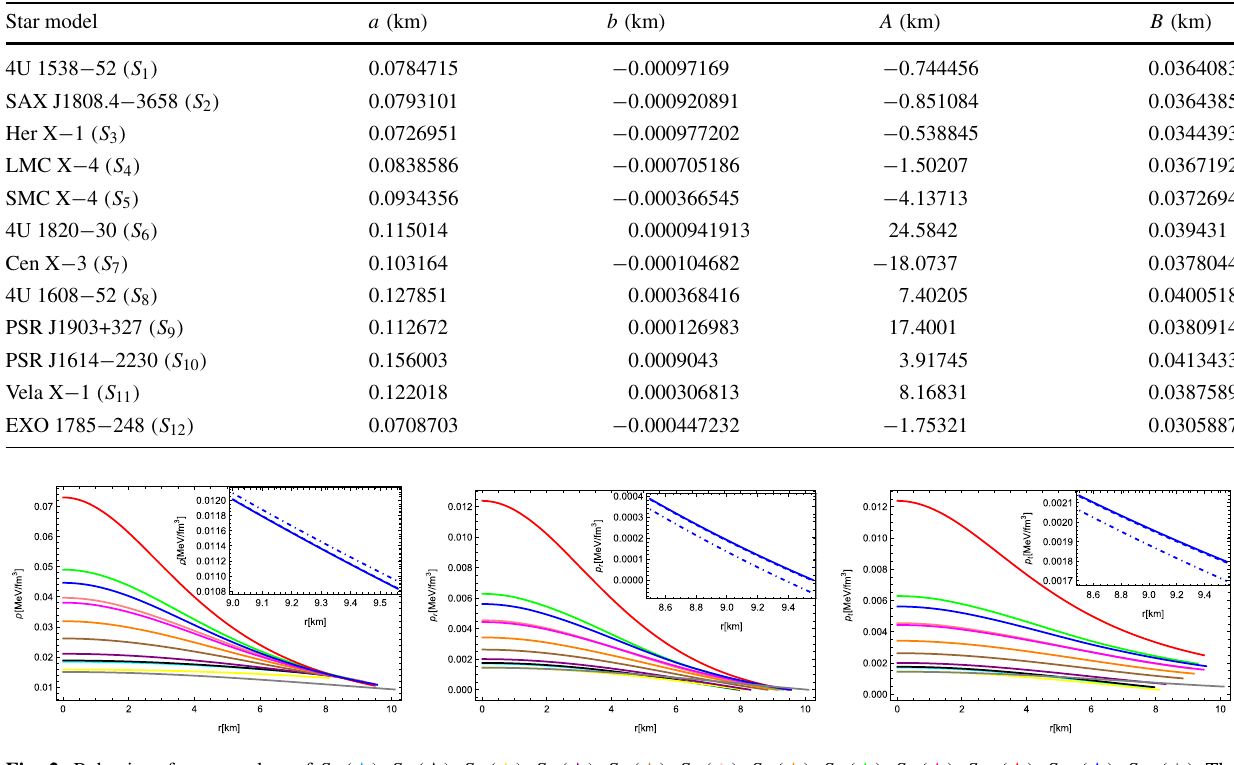
Fig. 2 Behavior of ρ , p r and p t of S 1 ( (cid:2) ), S 2 ( (cid:2) ), S 3 ( (cid:2) ), S 4 ( (cid:2) ), S 5 ( (cid:2) ), S 6 ( (cid:2) ), S 7 ( (cid:2) ), S 8 ( (cid:2) ), S 9 ( (cid:2) ), S 10 ( (cid:2) ), S 11 ( (cid:2) ), S 12 ( (cid:2) ). The magnified images in the figure show the behavior of the star Vela X − 1 for two different values of parameter α = 1 . 0 × 10 − 9 , α = 1 . 9 × 10 − 8